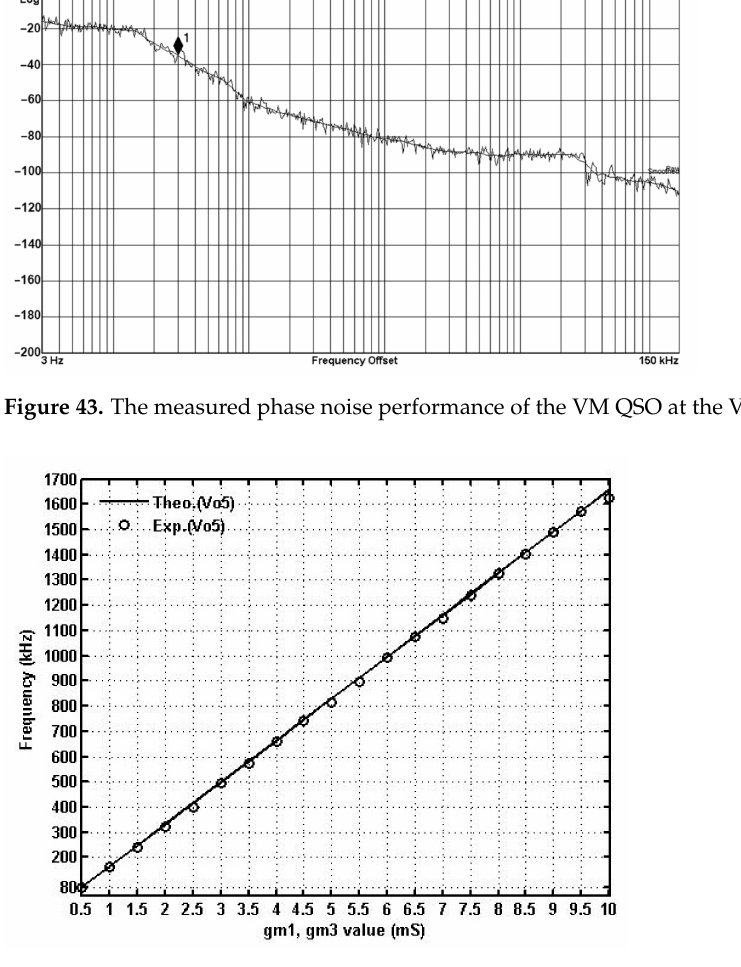
Figure 44. The experimental results of V o5 for g m1 = g m3 .